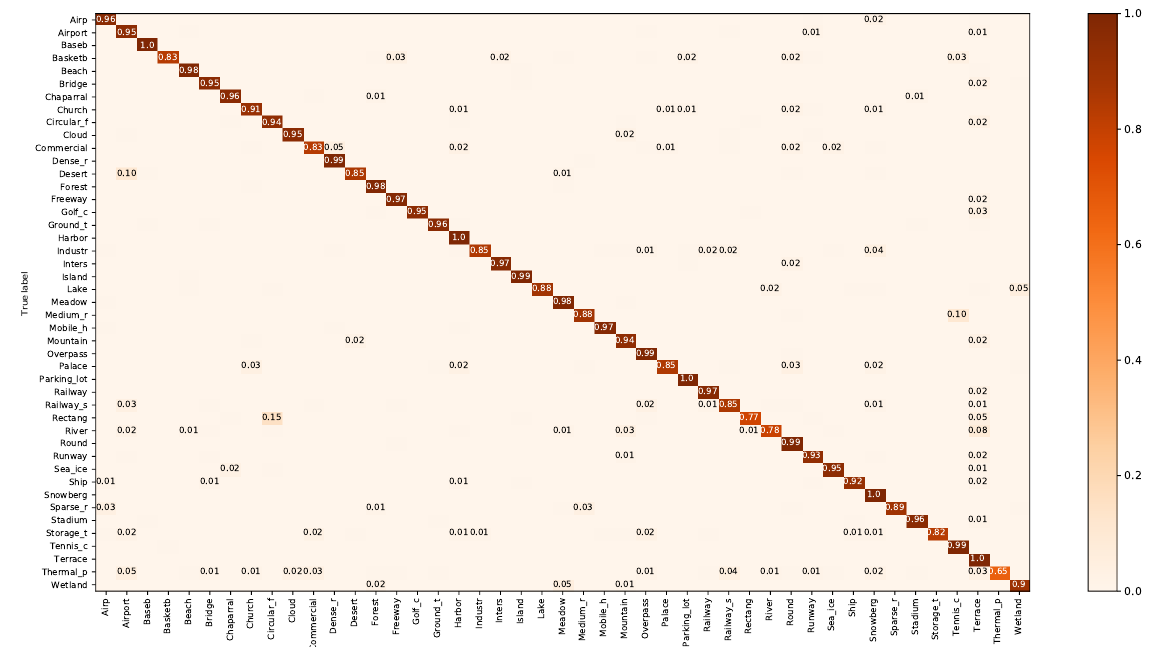
Figure 14. CM of the NWPU dataset for a 20% training ratio (only displays results greater than 0.01).